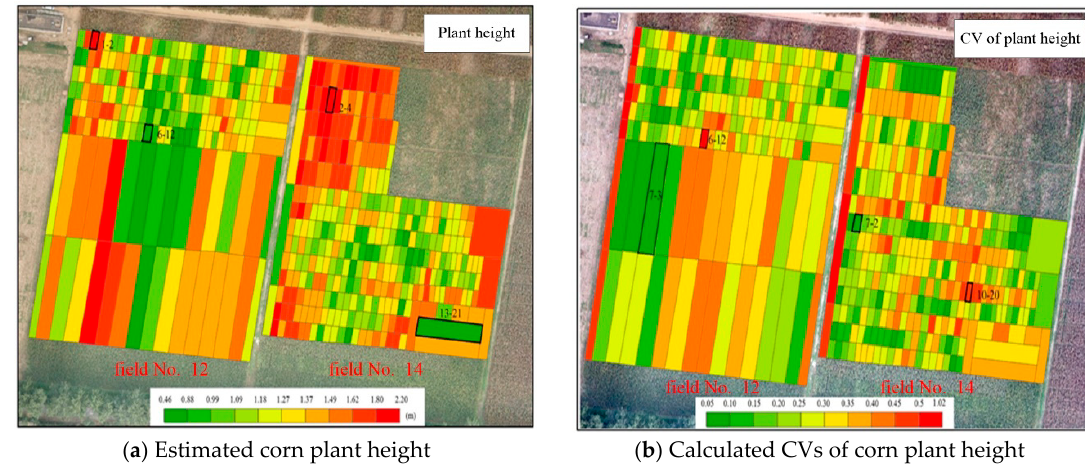
Figure 6. Mapping of corn plant height ( a ) and coefficients of variation (CVs) for different corn varieties ( b ) in the Shunyi breeding trial.